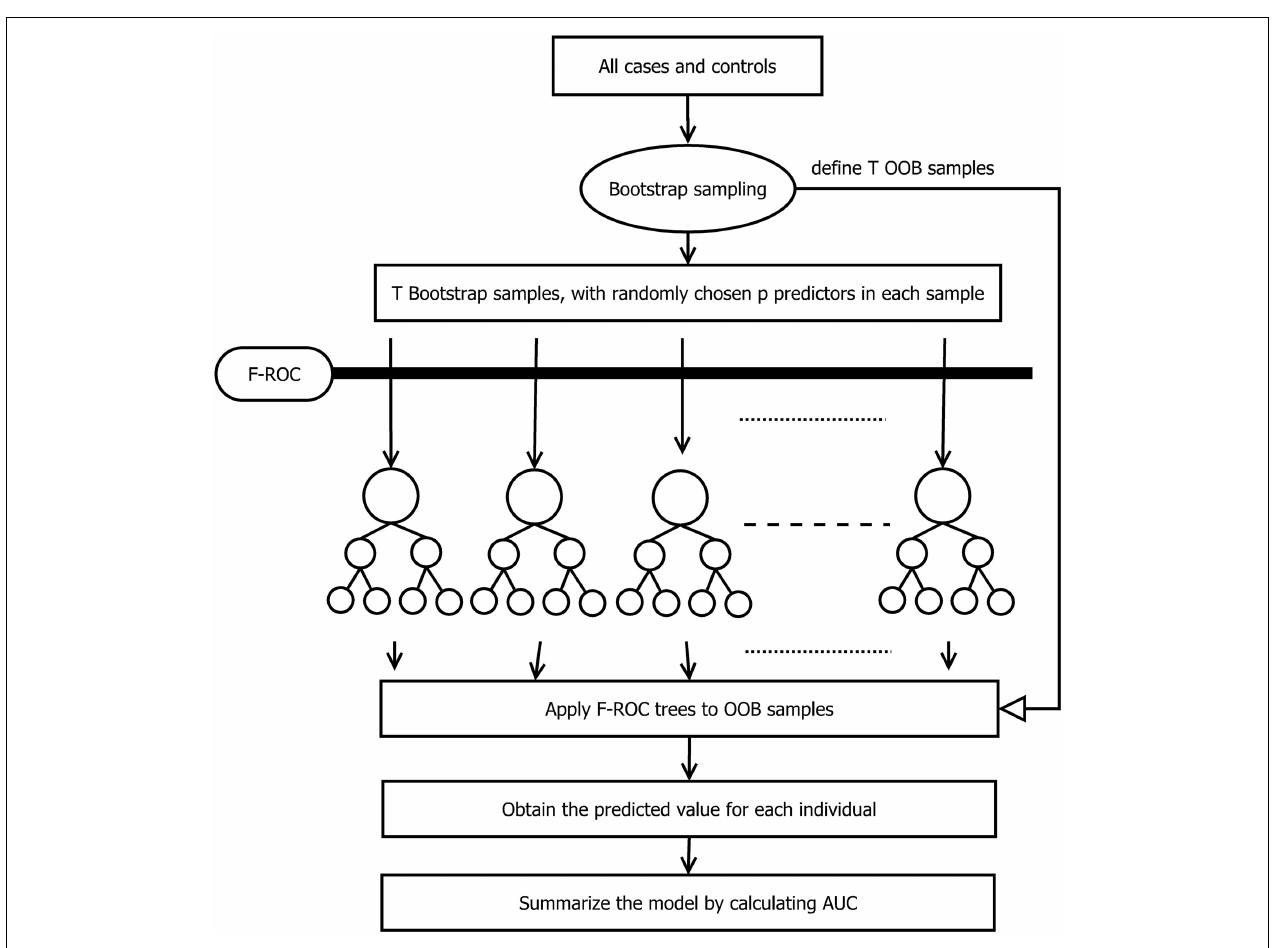
FIGURE 1 |The flowchart of theTA-ROC